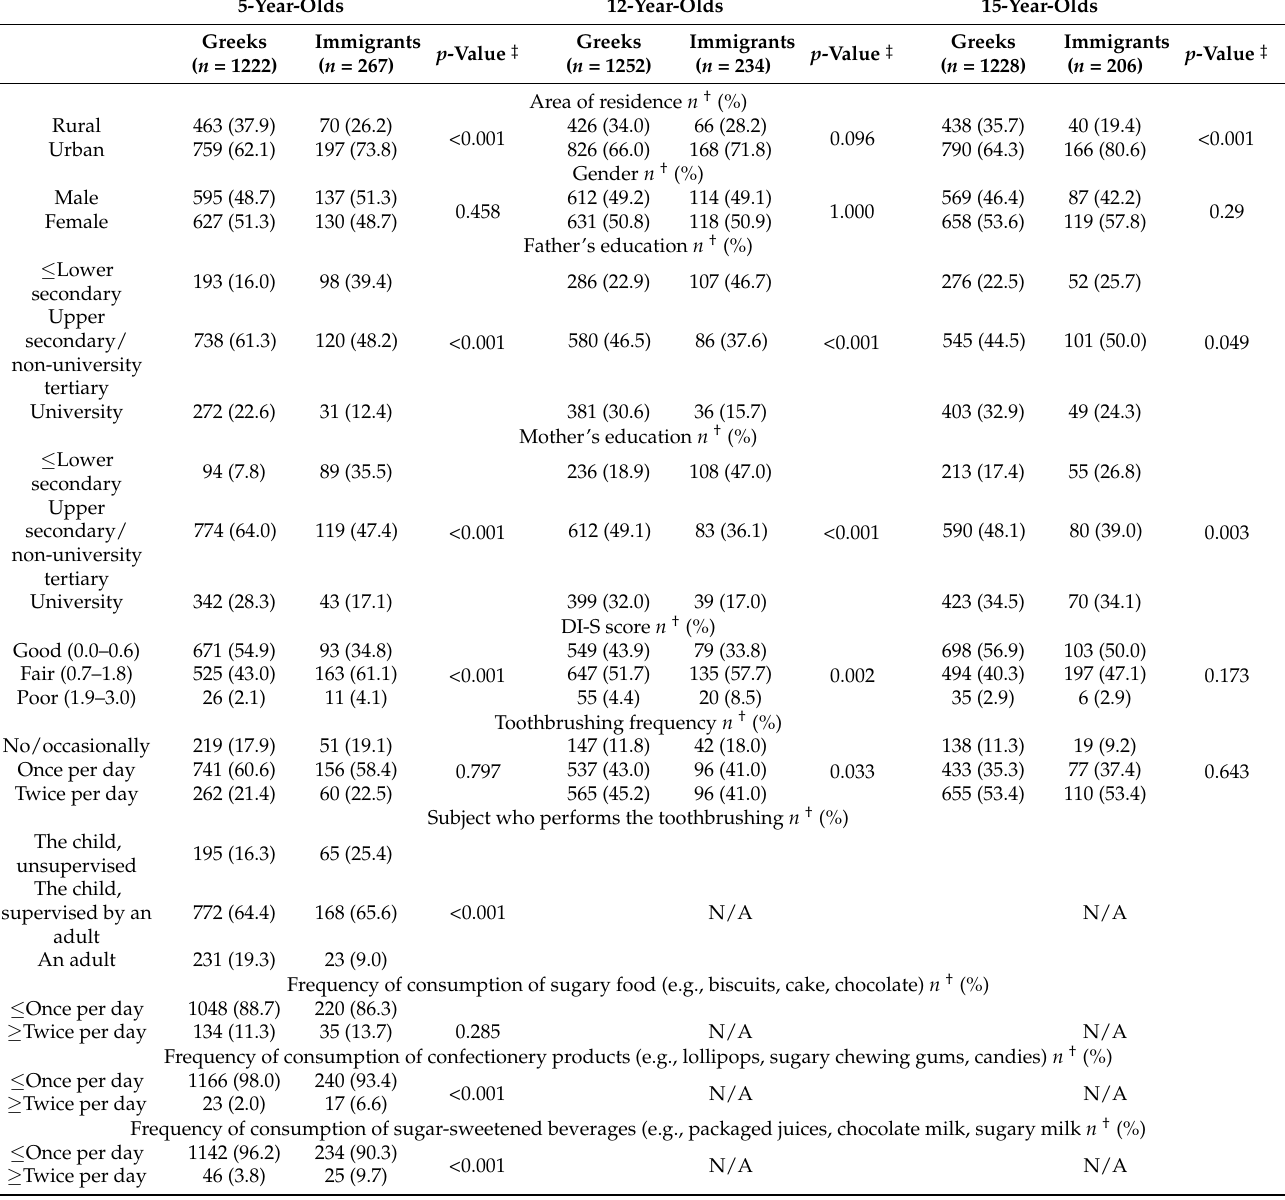
Table 5. Distribution of 5-, 12- and 15-year-old children and adolescents of immigrant and of native Greek origin according to location, gender, parental education level, oral hygiene practices, oral hygiene level (DI-S score) and dietary patterns (data available only for preschool